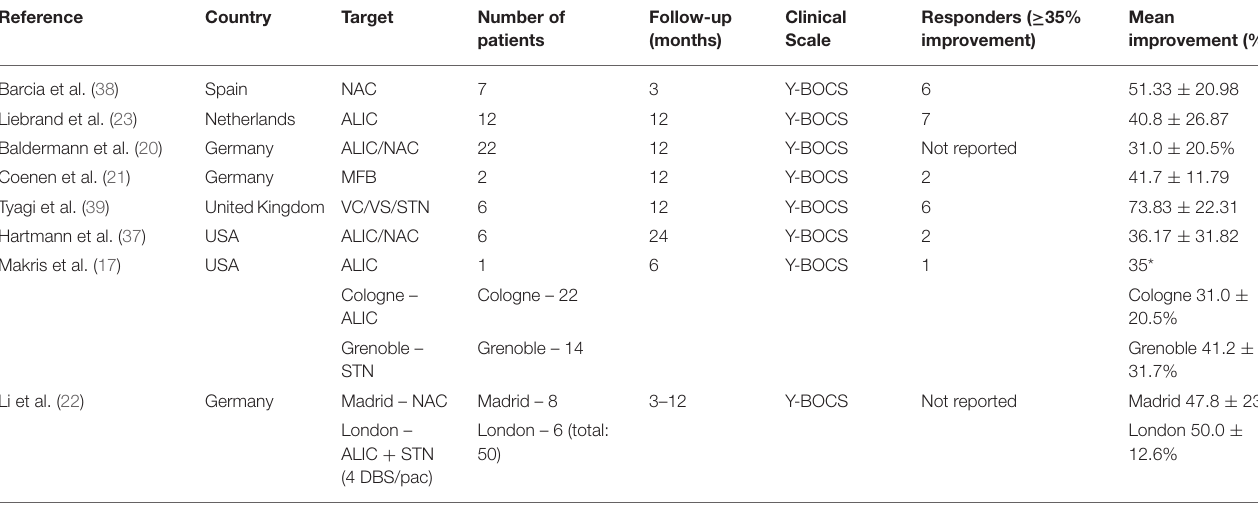
TABLE 1 | Characteristics of included